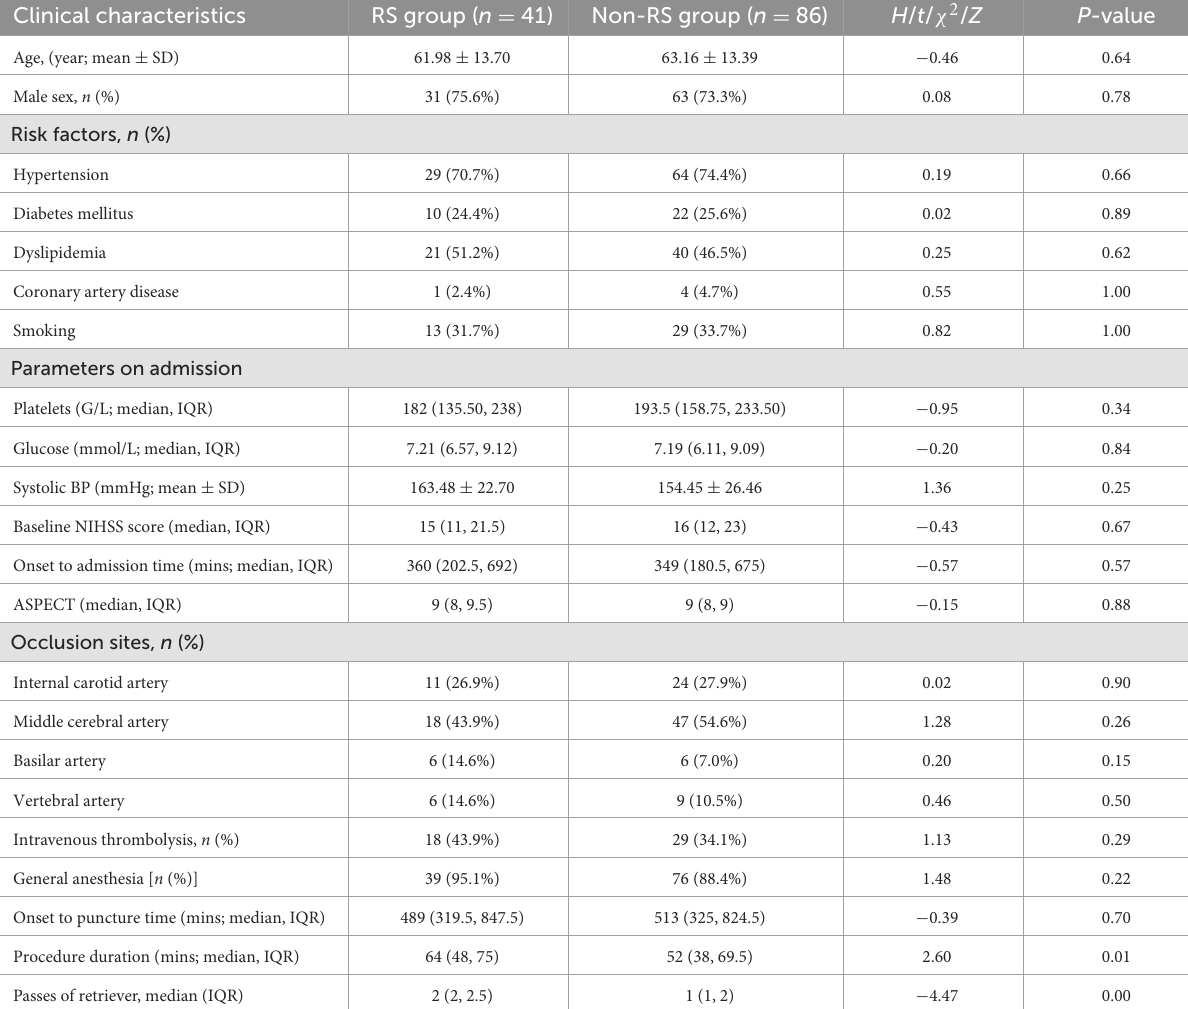
TABLE 1 Comparison of baseline demographics and clinical relevance characteristics among two groups.